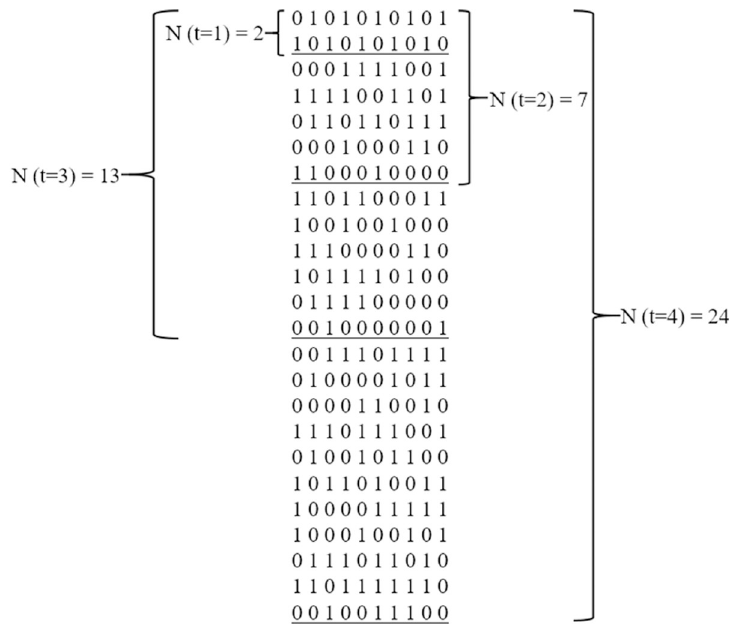
Fig 2. An example of an ICA (2, 7, 13, 24; 4, 10,